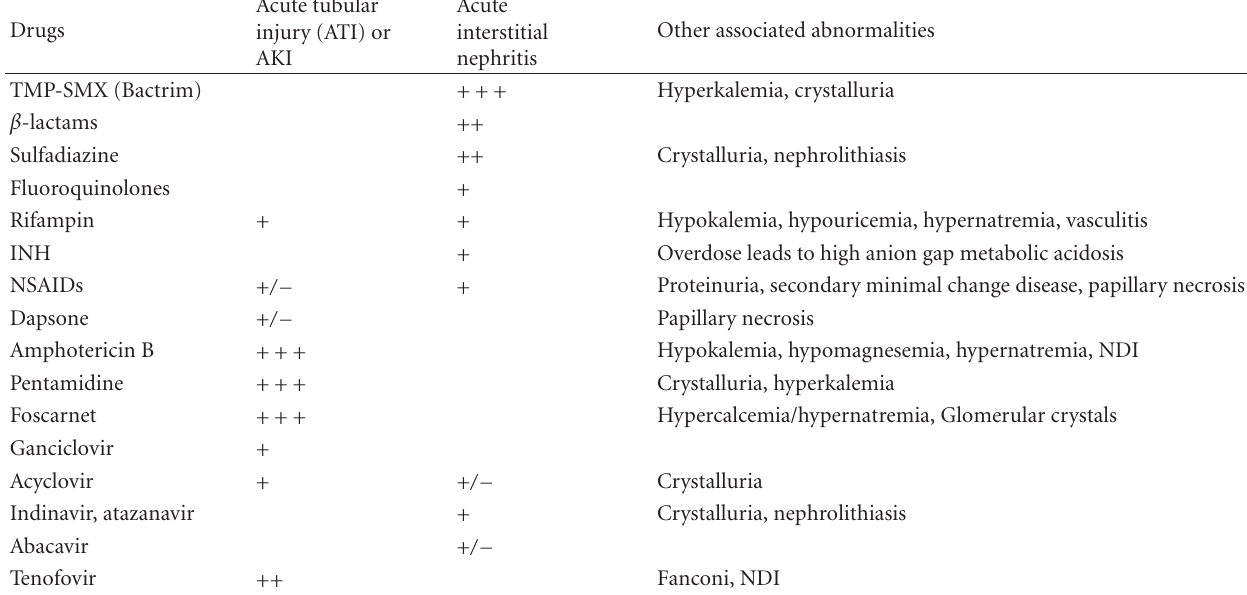
Table 2: Selective drugs causing AKI in HIV-infected